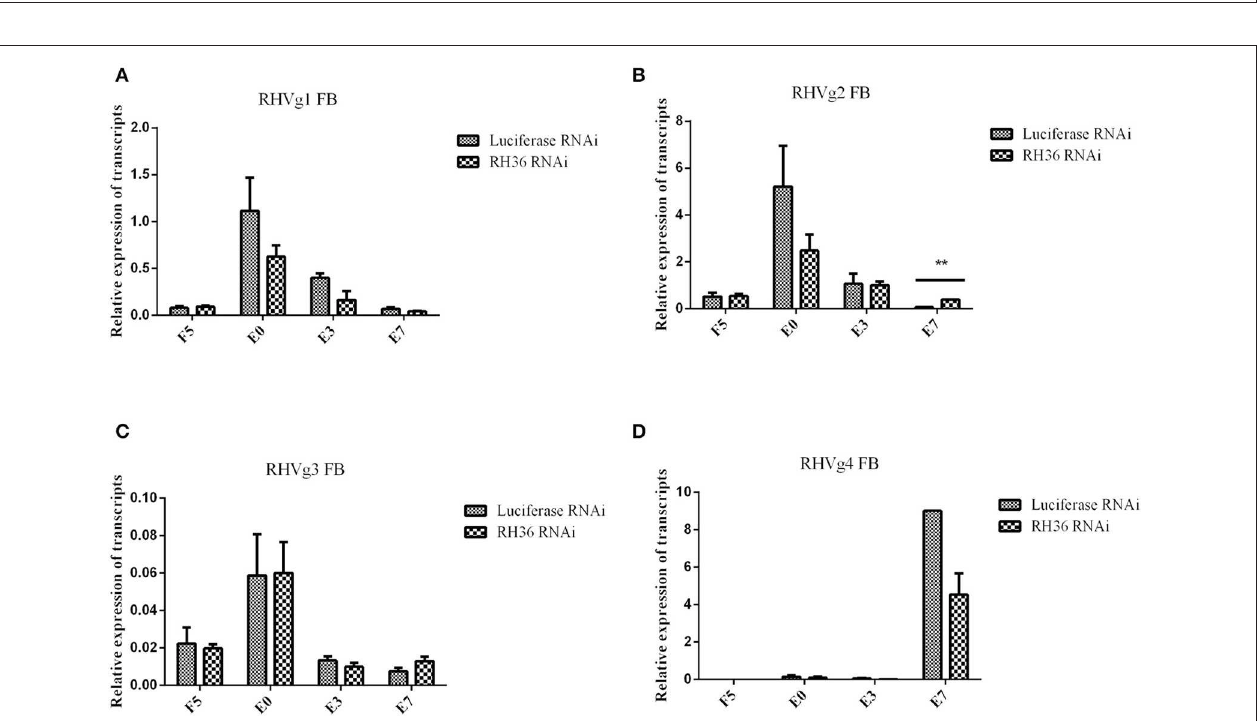
FIGURE 3 | Expression of RHVg mRNA in fat body of female ticks is not affected after RH36 gene silencing. Transcript levels of RHVg1 (A) , RHVg2 (B) , RHVg3 (C) , and RHVg4 (D) were detected in the fat body of 5-day-fed ticks, engorgement ticks, 3 day post-engorgement ticks and 7 day post-engorged ticks by real-time quantitative PCR. The data were normalized to tick elongation factor 1 α and gene-specific standards were the respective plasmids. RHVg2 mRNA was up-regulated significantly at 7 day post-engorgement ( p < 0.01), but there was no difference for other RHVg genes. ** means highly statistical significance that p -values less than 0.01. FB, fat body; F5, at day 5 for blood feeding; E0, on the day of engorgement; E3, at 3 days post-engorgement; E7, at 7 days after engorgement.